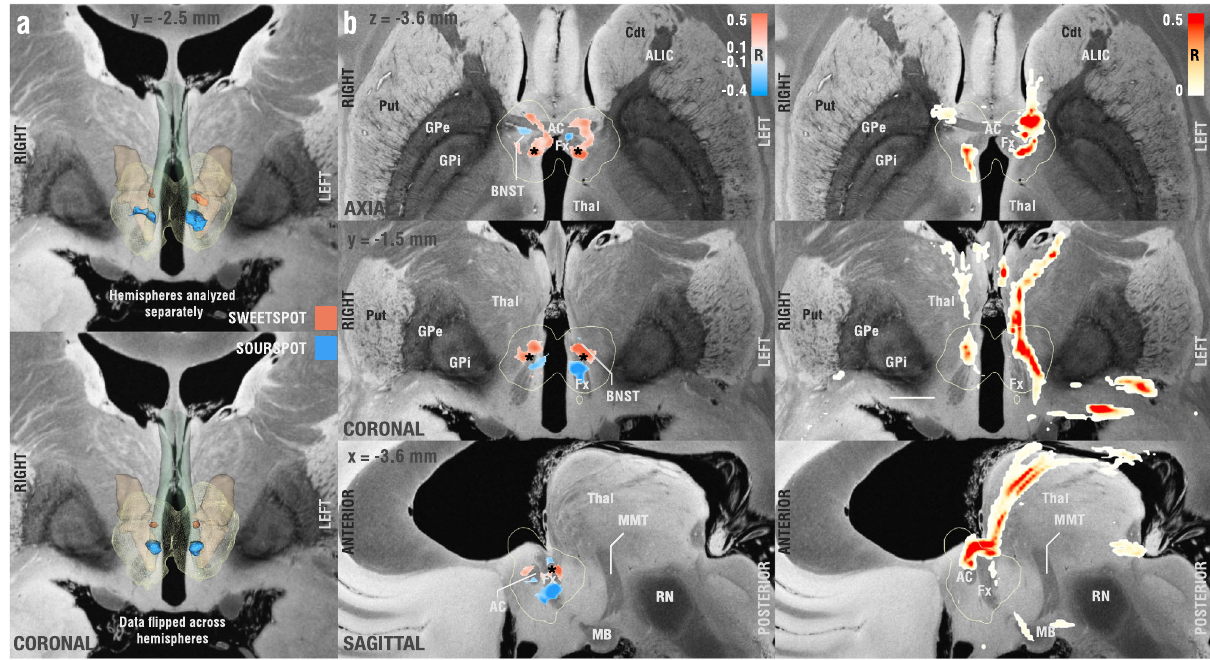
Fig. 3 | Probabilistic mapping of sweet and sour spots associated with clinical outcome. a Identi fi ed clusters of sweet (red) and sour (blue)-spots in a 3D view, superimposed on slices of a 100- µ m, 7T brain scan in MNI 152 space 83 . Since the result was symmetric, on the bottom of the panel, we fl ipped stimulation volumes across hemispheres to further increase robustness on a voxel-level (effectively doublingthenumberof electrodesusedineachhemisphere). b Axial,coronal,and sagittal views of sweet and sourspot peak coordinates (also see supplementary table 6). Projections of cluster center coordinates are marked by a black asterisk